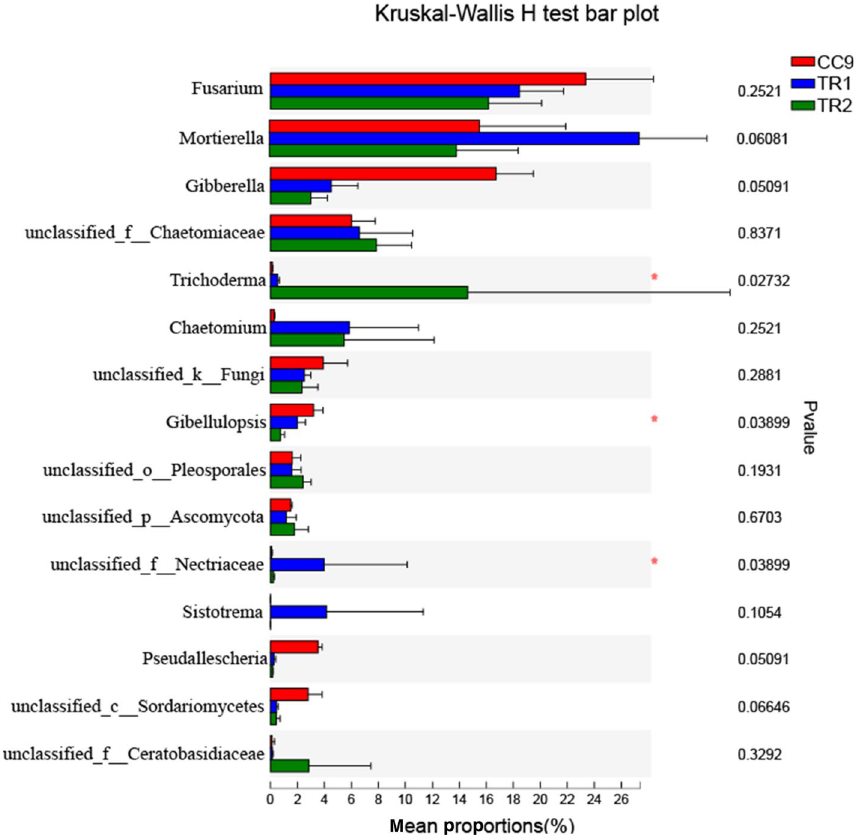
Figure 4. The relative abundances of the first 15 genera after the MHT1134 application. *0.01 < P ≤ 0.05. CC9 represent the plots where pepper had been continuously planted for 9 years, and TR1 and TR2 represent CC9 plots in which the MHT1134 biocontrol fermentation broth had been applied 1 and 2 years in advance,